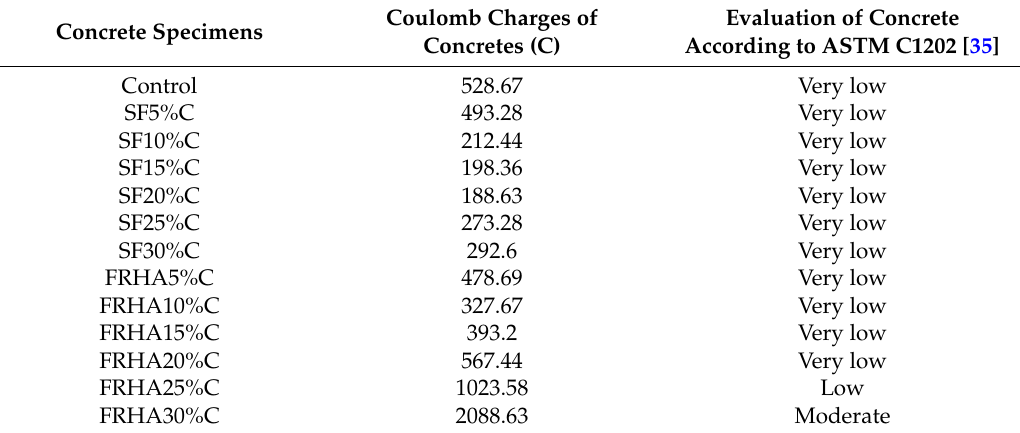
Table 7. Coulomb charges of concretes at 28